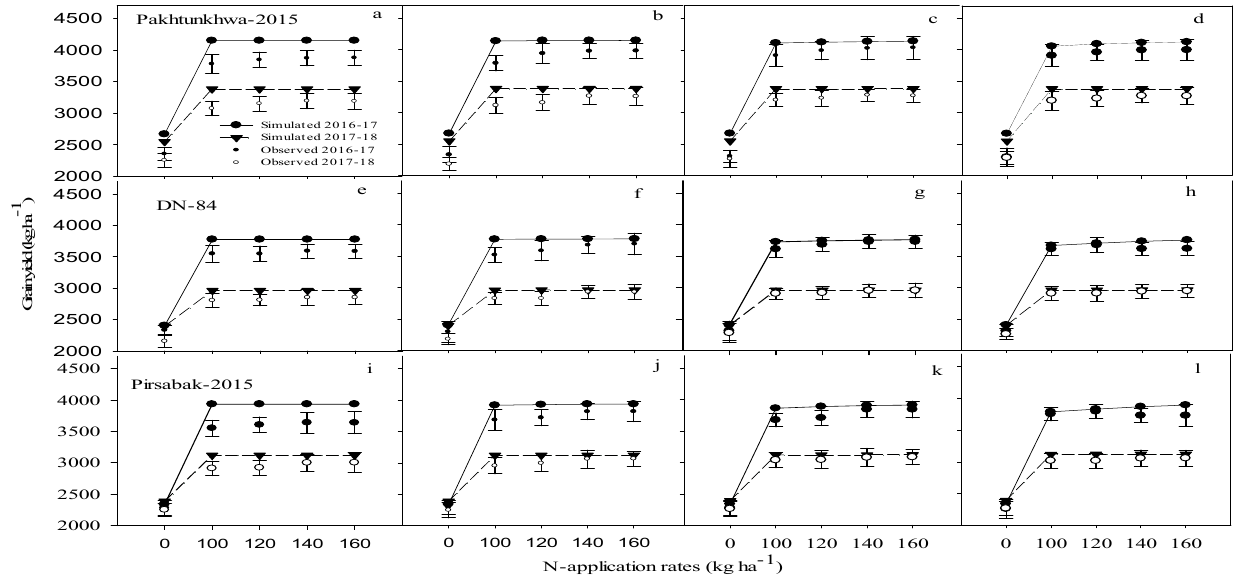
Figure 6. Using CSM-CERES-Wheat to predict grain yield (kg ha − 1 ) as a function of N application at different stages: full N application (N 100% ) at sowing ( a , e , i graphs), half of recommended N application (N 50% ) at sowing + N 50% at tillering ( b , f , j graphs), quarter of recommended N application (N 25% ) at sowing + N 50% at tillering + N 25% at booting ( c , g , k graphs), and N 25% at sowing + N 25% at tillering + N 50% at booting stage ( d , h , l graphs) for different cultivars.